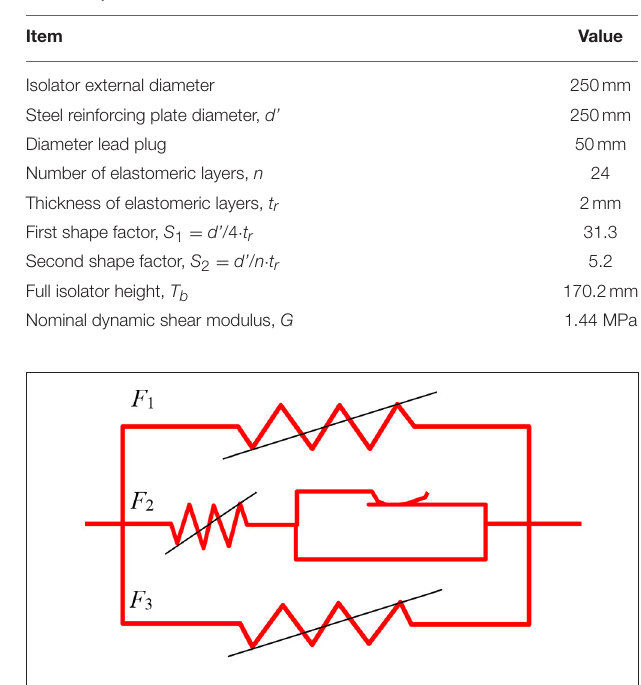
FIGURE 2 | Schematic representation of the Abe et al. (2004a,b) model.